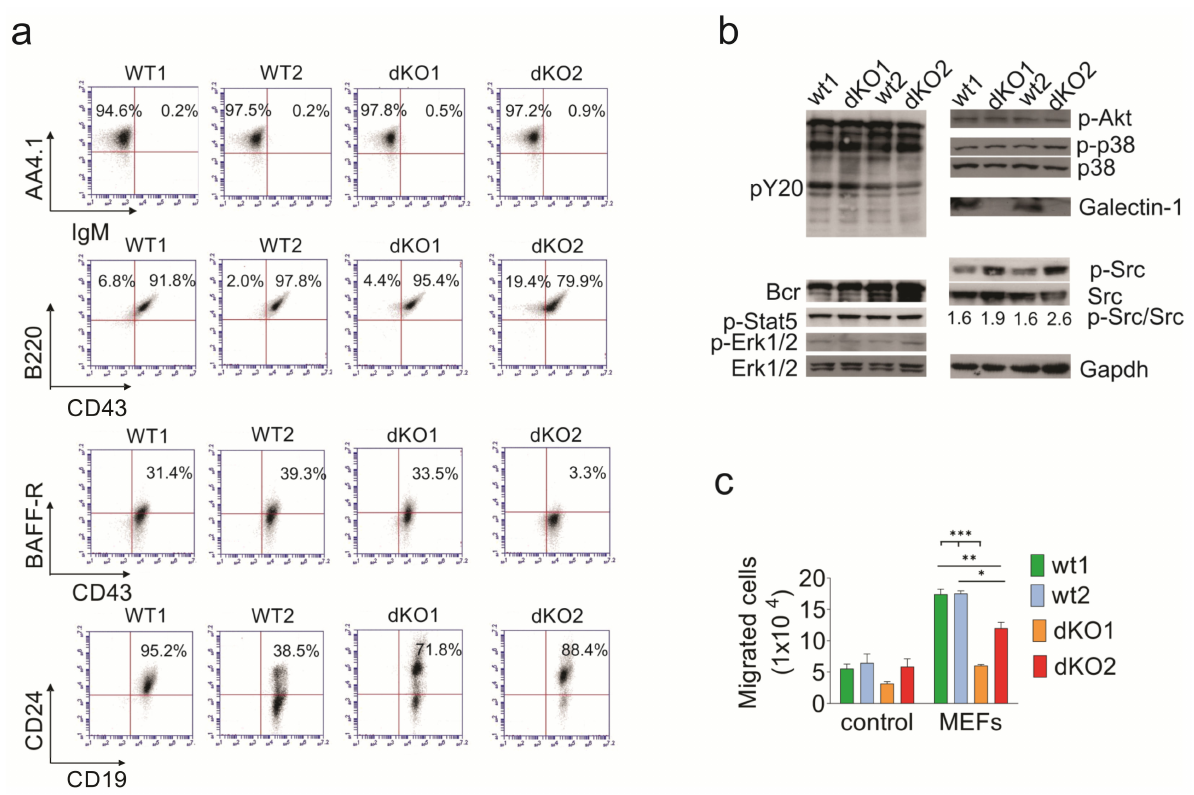
Figure 5. Characterization of murine Bcr/Abl-positive BCP-ALL cells lacking Galectin-1 and Galectin- 3 generated by transformation of Lgals1 × Lgals3 -/- or matched wt bone marrow cells with p190 Bcr/Abl. Samples include wild-type (wt) pre-B ALL #1 and #2, and Lgals3 × Lgals1-/- (dKO) pre-B ALLs dKO1 and dKO2, representing independent transductions. ( a ) FACS analysis for the indicated markers at week 3 after transduction. Gates were set using isotype controls. Numbers: % of cells in indicated quadrants. ( b ) Western blot analysis with the antibodies indicated to the sides of the panels. The ratio of pSrc/Src was determined by densitometric scanning of Western blot film images using ImageJ software version 1.51. Gapdh, loading control. BCP-ALL cells grown without stroma. ( c ) Mouse BCP-ALL wt1/wt2 and dKO1/dKO2 cells were plated in the upper wells of a Transwell and allowed to migrate overnight towards control medium or MEFs plated in the bottom well. * p < 0.05, ** p < 0.01, *** p < 0.001 for differences between wt and dKO samples migrating toward MEFs (n = 3 per sample per genotype), unpaired two-tailed t